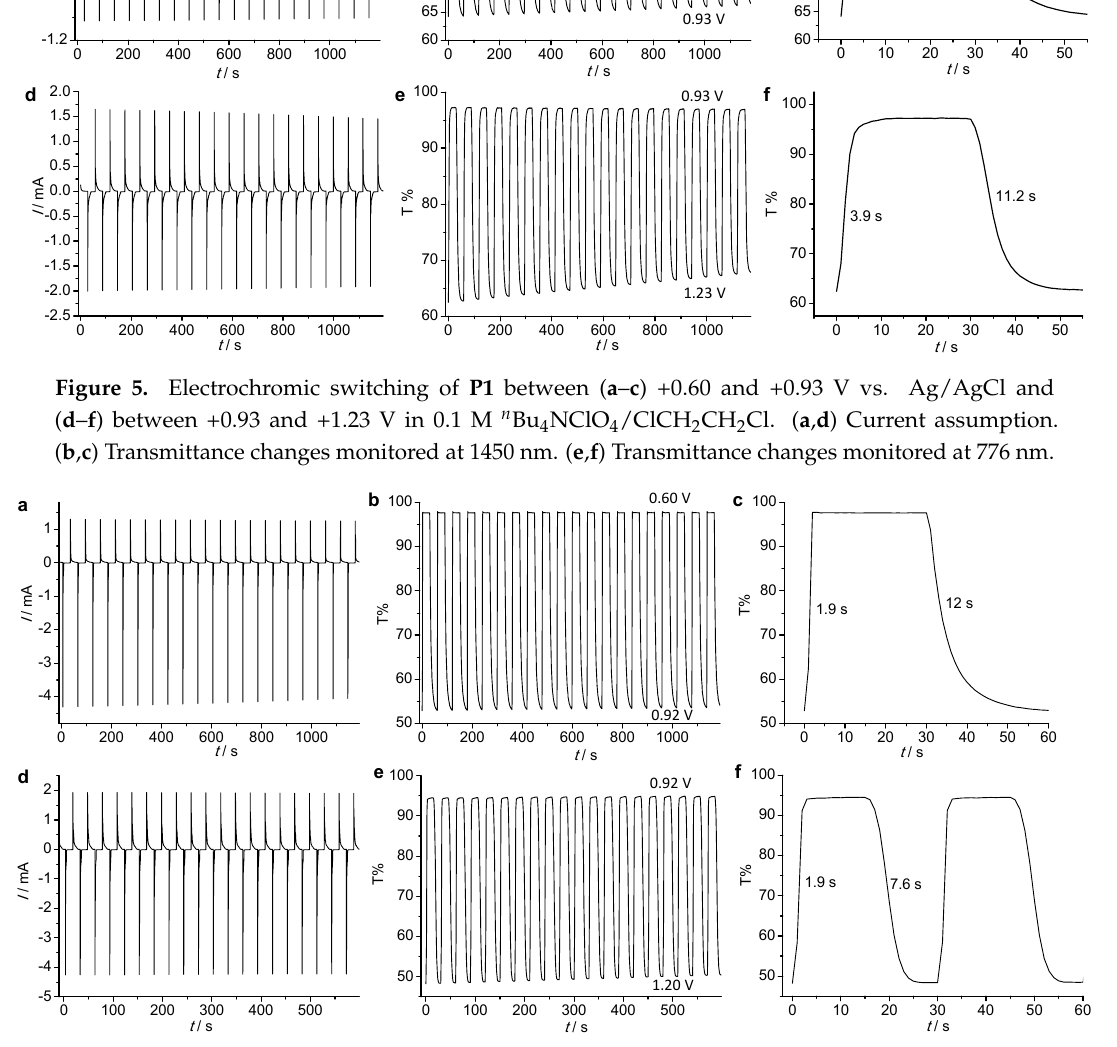
Figure 6. Electrochromic switching of P2 between ( a – c ) +0.60 and +0.92 V vs. Ag/AgCl and ( d – f ) between +0.92 and +1.20 V in 0.1 M n Bu 4 NClO 4 /ClCH 2 CH 2 Cl. ( a , d ) Current assumption. ( b , c ) Transmittance changes monitored at 1475 nm. ( e , f ) Transmittance changes monitored at 862 nm.